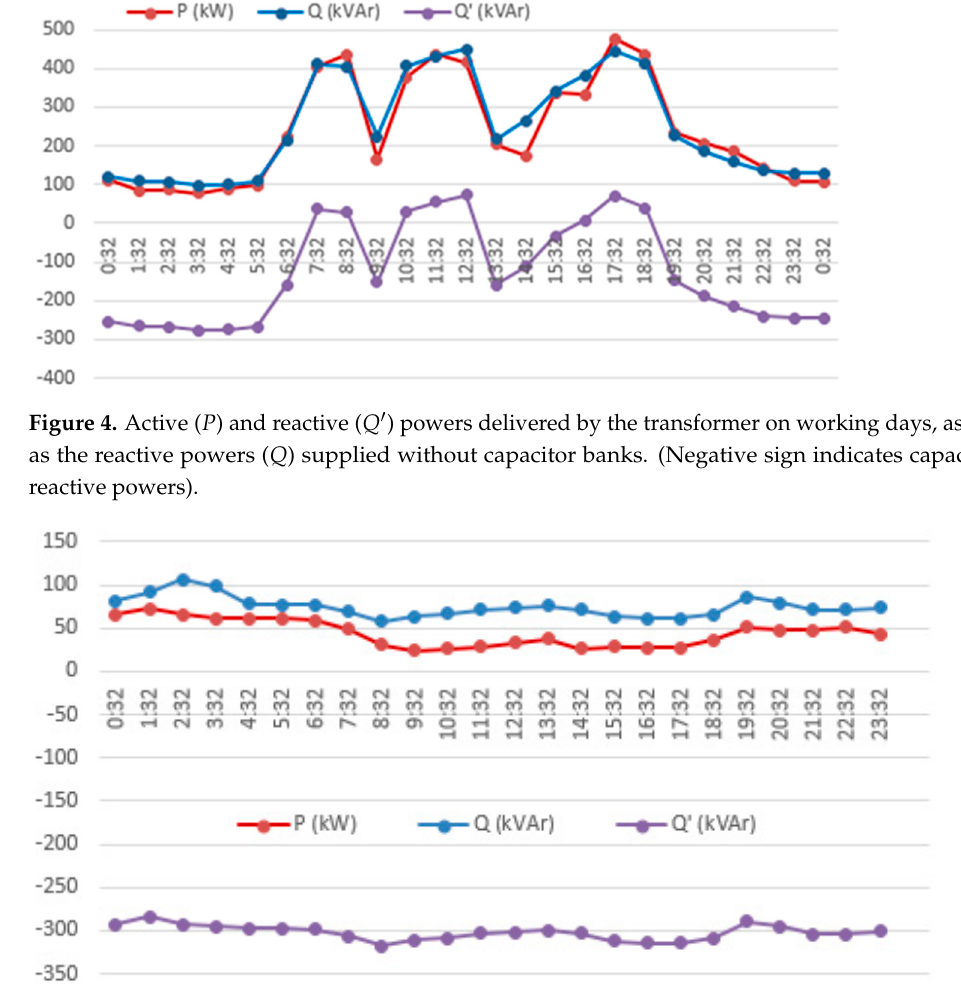
Figure 5. Active ( P ) and reactive ( Q (cid:48) ) powers delivered by the transformer during holidays, as well Figure 5. Active ( 𝑃 ) and reactive ( 𝑄′ ) powers delivered by the transformer during holidays, as well as the reactive powers ( Q ) supplied without capacitor banks. (Negative sign indicates capacitive as the reactive powers ( 𝑄 ) supplied without capacitor banks. (Negative sign indicates capacitive reactive reactive powers).